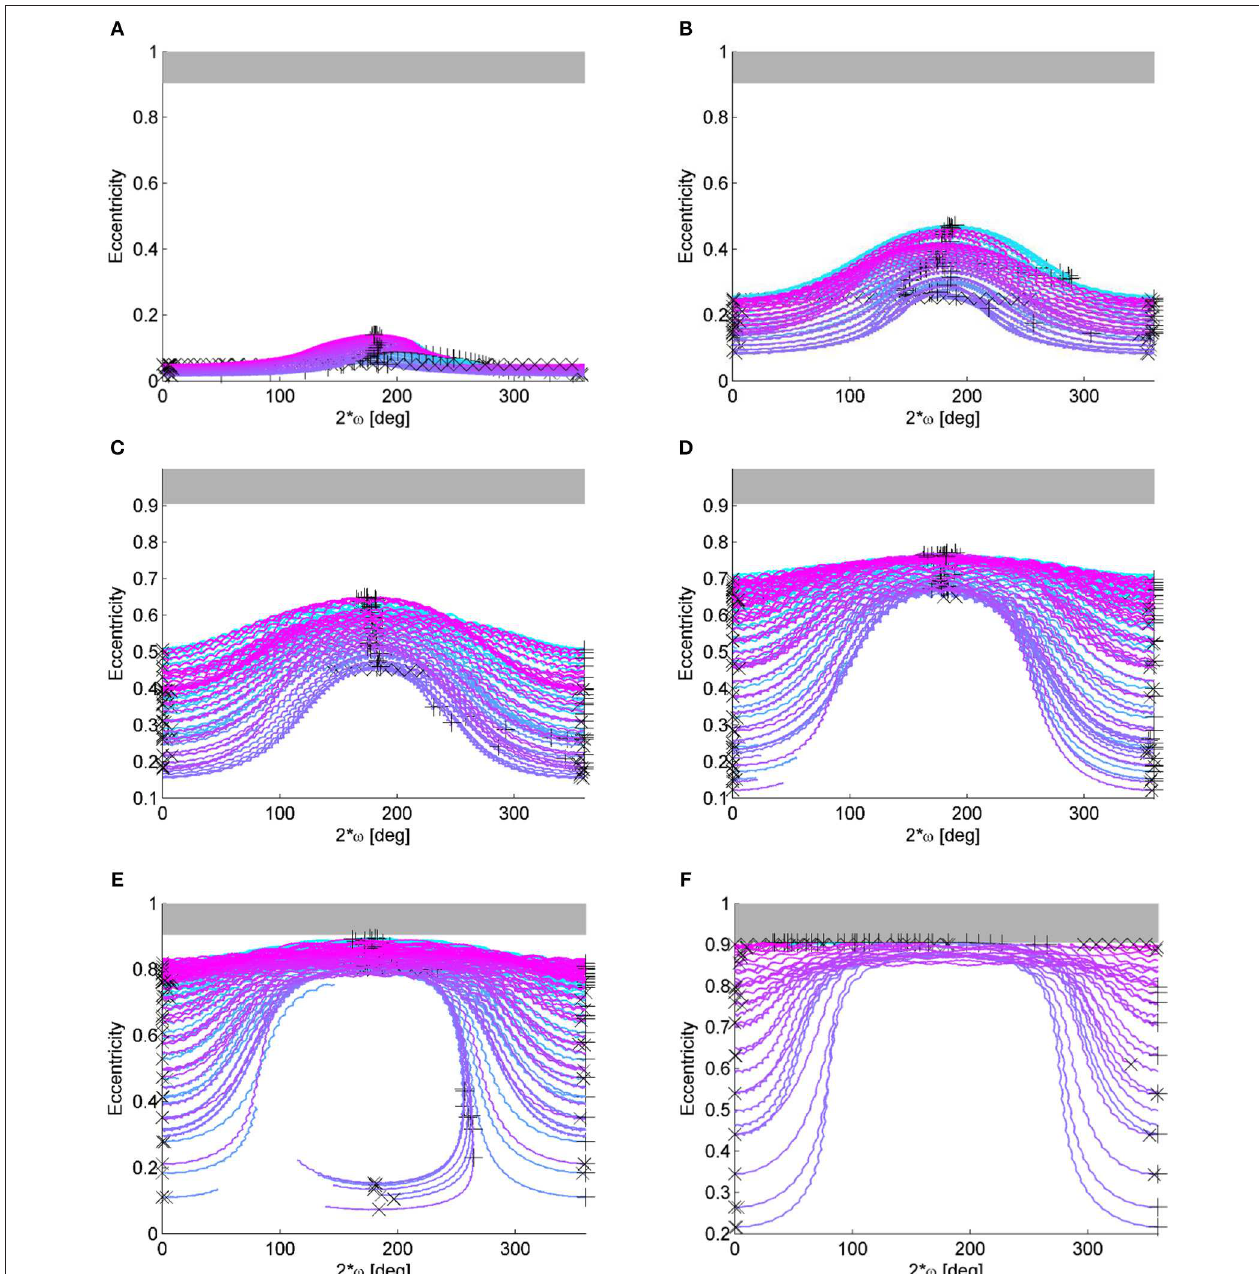
FIGURE 8 | Maps for initial inclination with respect to the Moon’s plane of 45 ◦ and semi-major axis equal to 67045.39km. The initial inclination and the argument of the perigee are measured with respect to the Moon’s plane. (A) Eccentricity-2 ω plot for e 0 e 0 0.45. (D) Eccentricity-2 ω plot for e 0 =